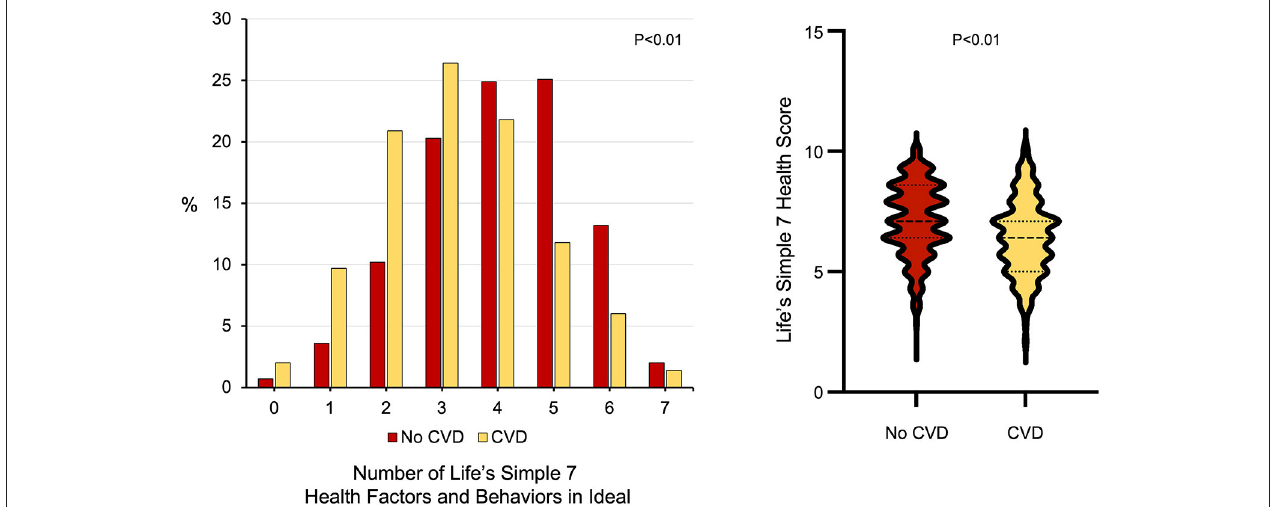
FIGURE 1 | Ideal cardiovascular health in participants aged < 50 years old with and without cardiovascular diseases. (Left) The number of Life’s Simple 7 health factor and behavior categories scored as ideal for young adults with cardiovascular disease ( n = 349) compared to those without cardiovascular disease ( n = 696). P < 0.01 by Wilcoxon rank-sum test. (Right) Life’s Simple 7 Health Score in young adults with cardiovascular disease compared to those without cardiovascular disease. P < 0.01 by Wilcoxon rank-sum test.